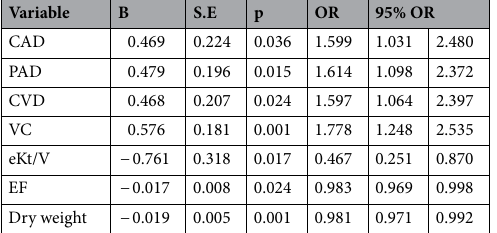
Table 2. Independent factors that predict the risk of death (n = 1034). CAD coronary artery disease, PAD peripheral artery diseases, CVD cerebrovascular diseases, VC valve calcifications, eKt/V effective Kt/V, EF ejection